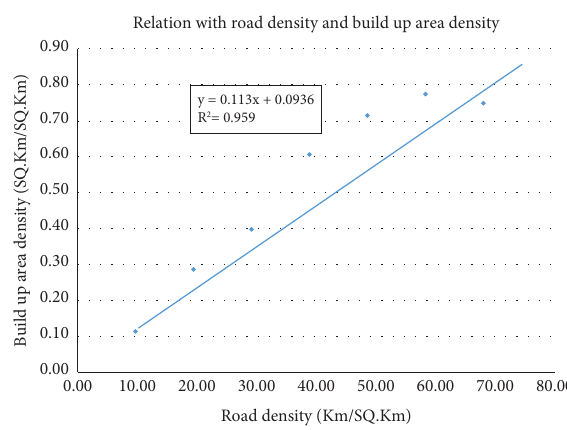
Figure 5: Relation with road density and build-up